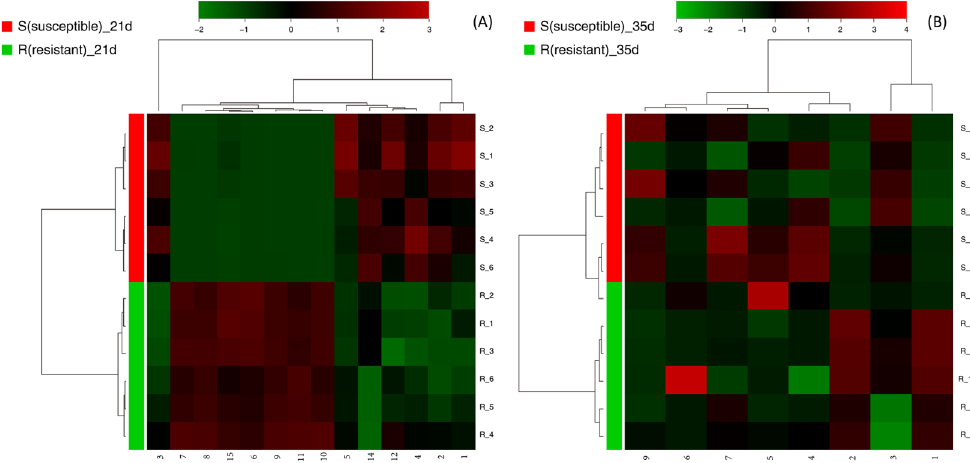
Figure 11. Heatmaps for serum metabolites on day ( A ) 21 and ( B ) 35. Colour of each section is proportional to significance level of change in metabolites (red, upregulated and green, downregulated). Rows: samples; Columns: metabolites; Numbers consistent with Tables 1 and 2.